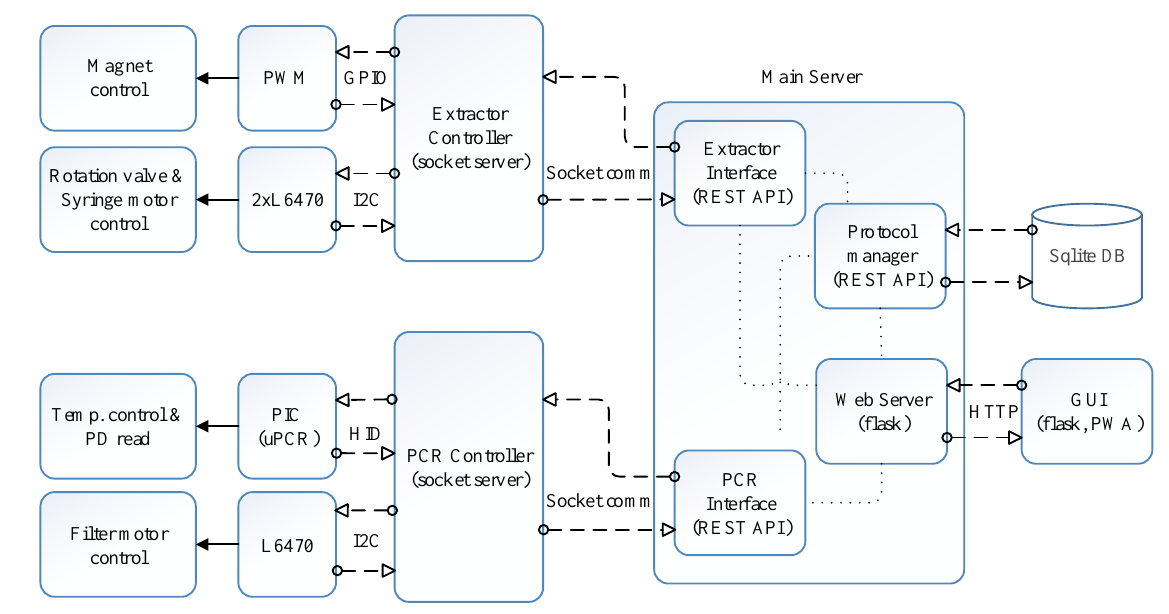
Figure 4. Software architecture block diagram.